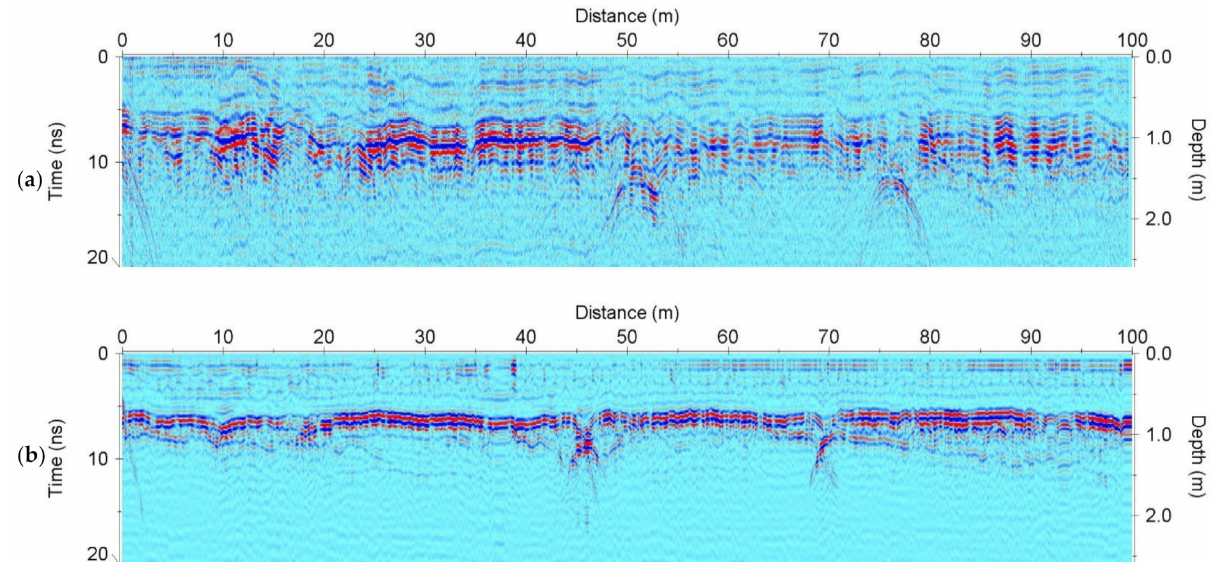
Figure 9. Comparison between drone-based ( a ) and ground-based ( b ) GPR sections over the same path. Paths are shown in Figure 3, and the ground-based profile was cut to match the beginning of the drone-based one. Three hyperbolas show the same (unidentified) targets under the snow. Comparing the hyperbolas positions, the match is good but suffers from the drone’s curvilinear